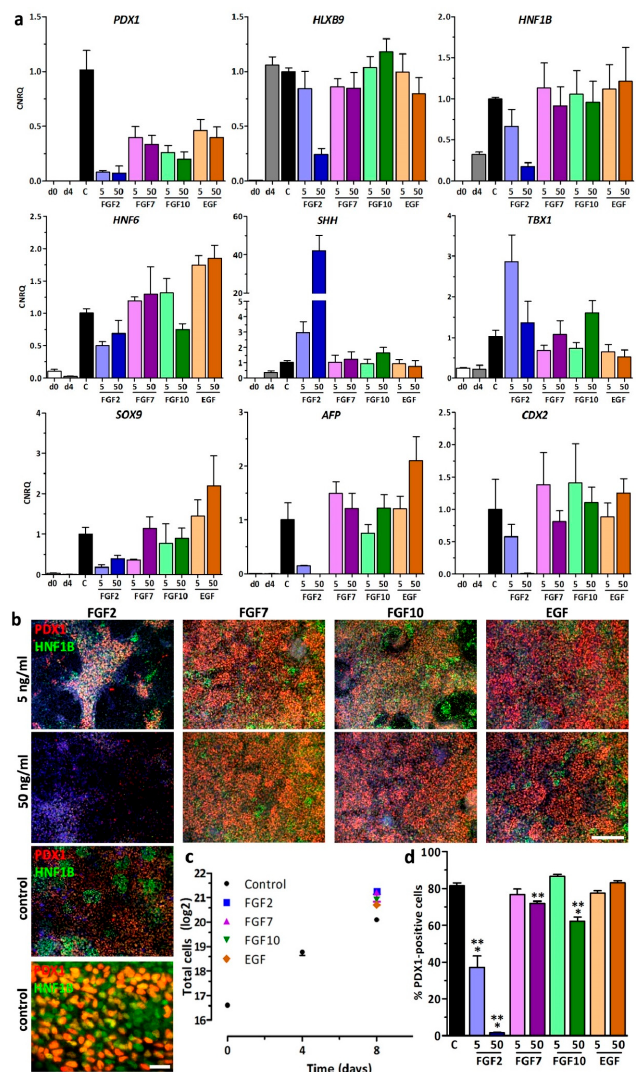
Figure 1. Pancreatic di ff erentiation in presence of growth factors. ( a ) Gene expression of PDX1 , HLXB9 , HNF1B , HNF6 , SHH, TBX1, SOX9, AFP, and CDX2 measured by RT-qPCR in human embryonic stem cells (hESC)s at d0, d4, and d8 of di ff erentiation treated ± 5 or 50 ng / mL fibroblast growth factor (FGF)2, FGF7, FGF10, or epidermal growth factor (EGF) in stage 2 medium. Values are means ± SEM, n = 4–6. 5 / 50 = 5 or 50 ng / mL growth factor, C = control medium without growth factors. ( b ) Fluorescence micrographs after pancreatic di ff erentiation illustrating the protein expression of PDX1 / HNF1B after a 4-day treatment ± 5 or 50 ng / mL FGF2, FGF7, FGF10, and EGF. Nuclei were counterstained with DAPI. Scale bar = 200 µ m and 20 µ m for higher magnification of the control. ( c ) Quantification of cell expansion using ± 50 ng / mL growth factor. Data are presented as mean (log2) ± SEM, n = 3. ( d ) Quantification of PDX1-positive cells upon treatment ± 5 or 50 ng / mL FGF2, FGF7, FGF10, and EGF at d8. Percentages are expressed as means ± SEM. *** = p ≤ 0.001, ** = p ≤ 0.01 compared to control, ANOVA plus Dunnett’s